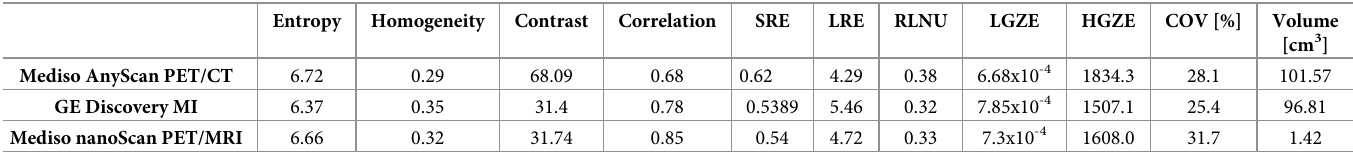
Table 4. The values of the heterogeneity parameters of the same pattern measured in three PET